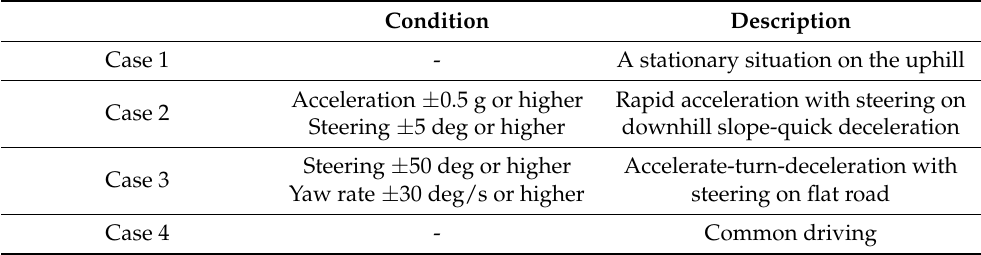
Table 3. Roll/pitch estimator validation